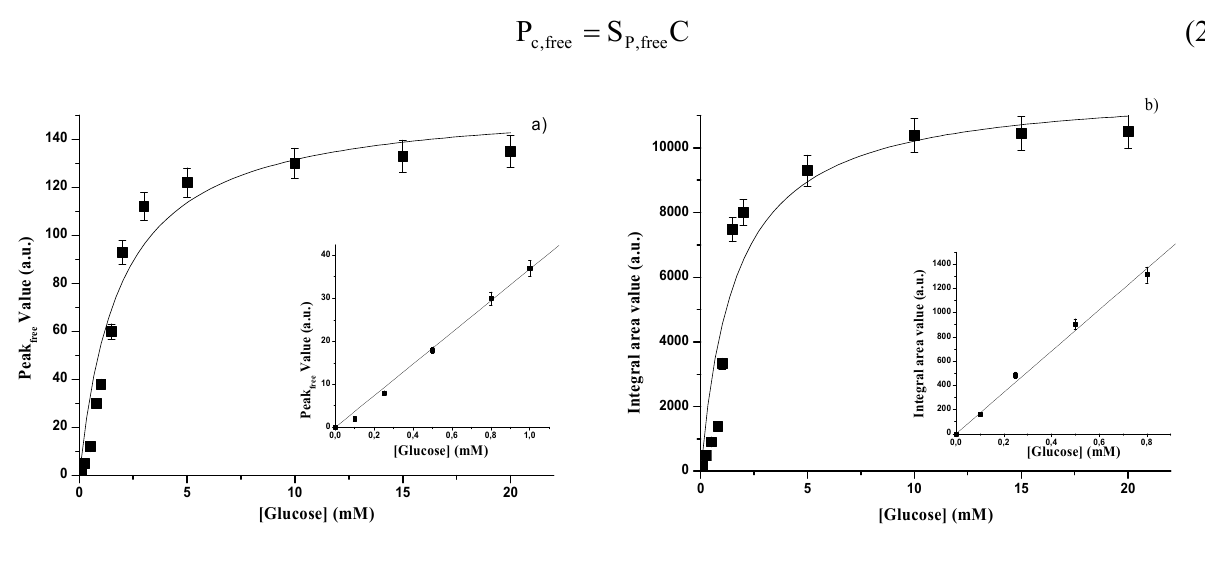
Figure 3. Free GOD - (a) Fluorescence emission peak as a function of glucose concentration. Inset: glucose calibration curve. (b) Fluorescence emission integral area as a function of glucose concentration. Inset: glucose calibration